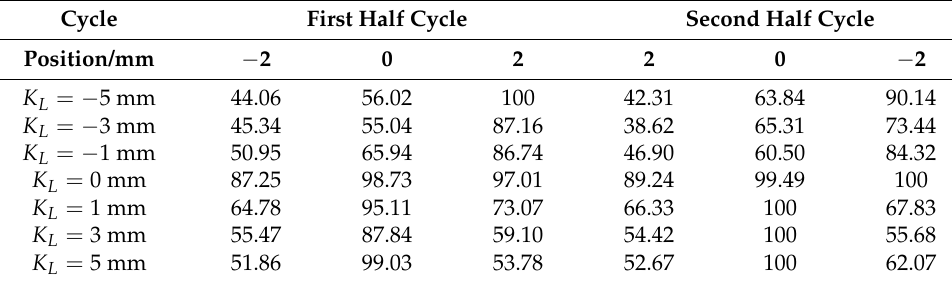
Table 1. The velocity ratio of the beam at different